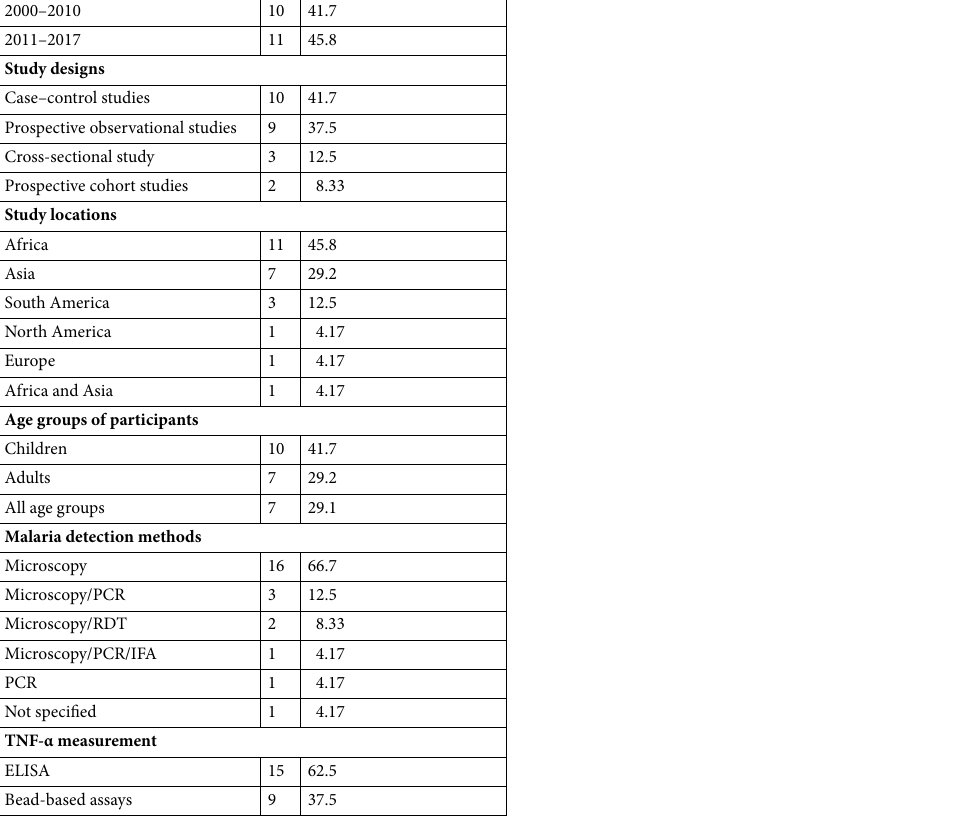
Table 1. Characteristics of the 24 included